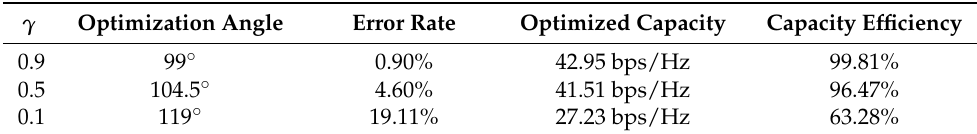
Table 11. Optimized values for antenna downtilt and channel capacity with different discount rates at D = 150 m.